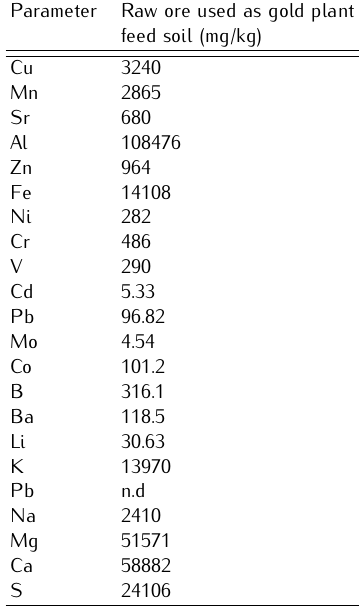
Table 2. Concentrations of heavy metals in soil